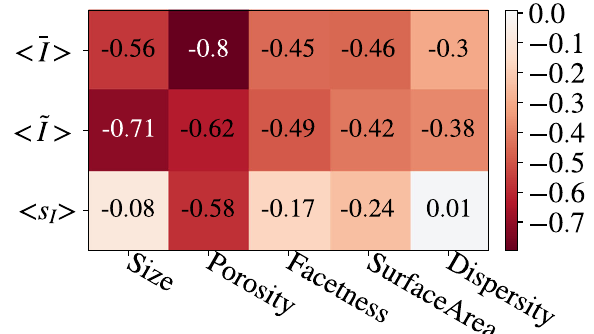
Fig. 3 Microstructure feature correlations with image intensities. Figure shows correlations between lot-average image intensity measurements (rows) and microstructure characteristics (columns), using all